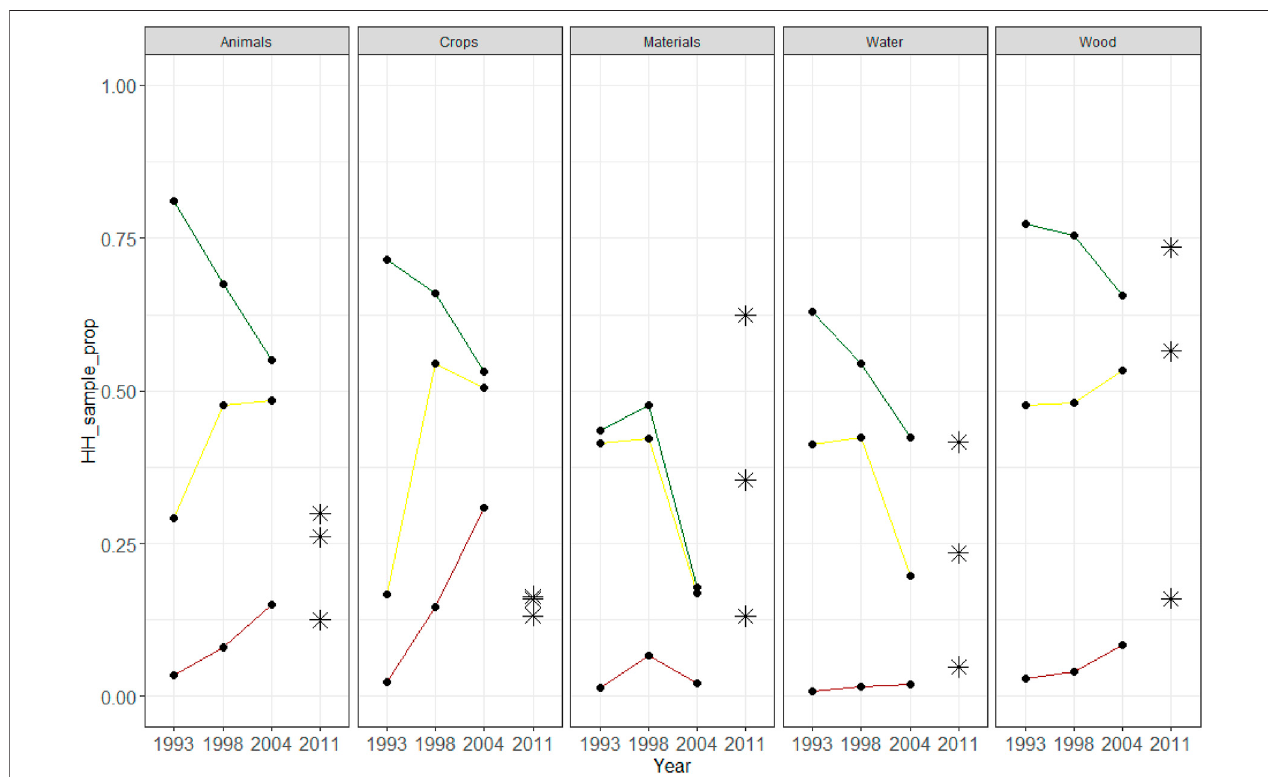
FIGURE3| EvolutionofaveragedirectESuseinKwaZulu-Natalbetween1993and2004atmunicipalitylevel.Greenlinescorrespondtogreenloopsyellowlinesto transition loops and red lines to red loops. Results from 2011 reported with stars for comparison. Standard errors (se) are within the range of se ε (0.008; 0.042). Data: KIDS 1993 – 2004 and 2011 census data. Note: The analysis relies on the clustering of a municipality as green, transition or red loop in 1993 to observe changes within that municipality over subsequent data collection waves. Due to limited comparability between KIDS and census data and some inconsistencies seem apparent (e.g. , “ Materials ” where the data waves between 2004 and 2011 are not reasonably